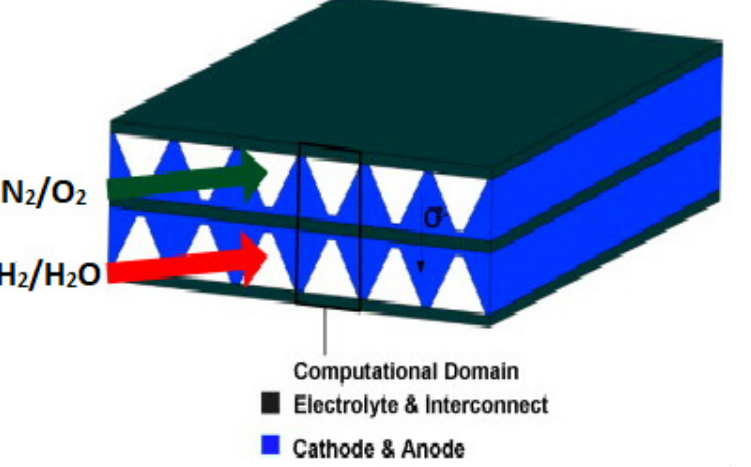
Figure 6. Multi-cell MEA concept developed at Rolls-Royce (figure reprinted from Gardner et al. [47] Copyright (2000), with permission from Elsevier).